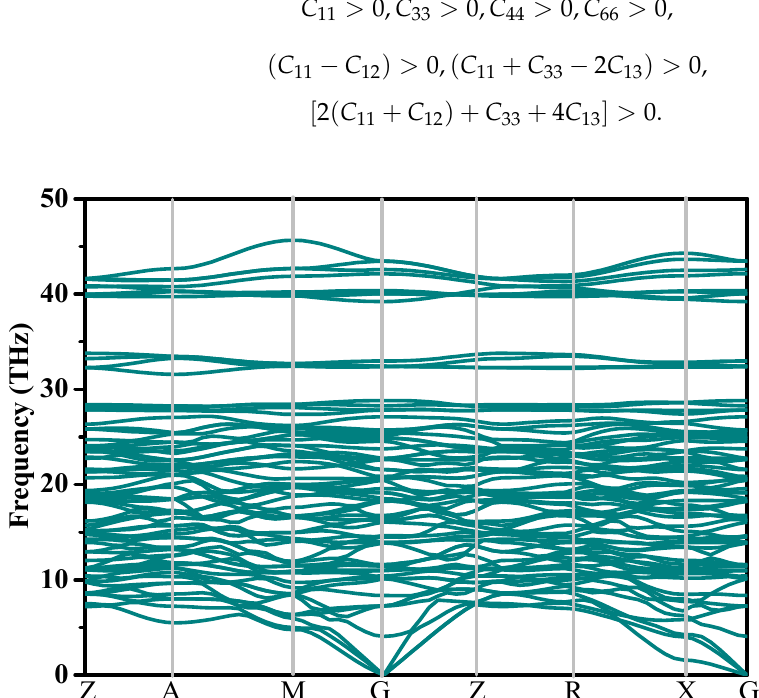
Figure 2. Phonon spectra of P 4/ m BN.